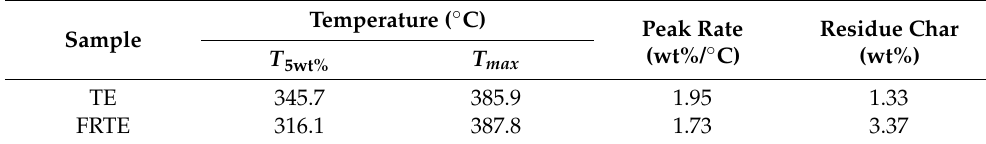
Figure 3. Thermal stability of TE composites. Table 1. TGA data of TE composites.